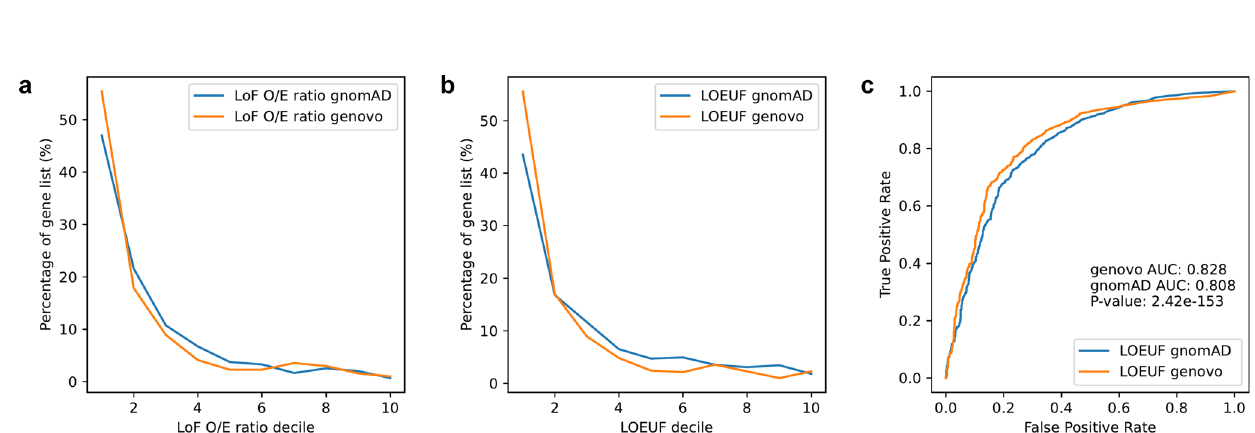
Fig. 6 | Inferring constraint of haploinsuf fi cient genes. a Comparison of observed/expected ratio for loss of function variants (LoF O/E ratio) inferred by Genovo and gnomAD (blue and orange, respectively). The x axis depicts LoF O/E ratiossortedintodeciles,whereasthe y axisdepictsthepercentageofgenesineach decile. Depicted numbers are shown in Supplementary Table 2. b Comparison of categorizationbyLOEUFscoresinferredbyGenovo-andLOEUFscorebygnomAD.